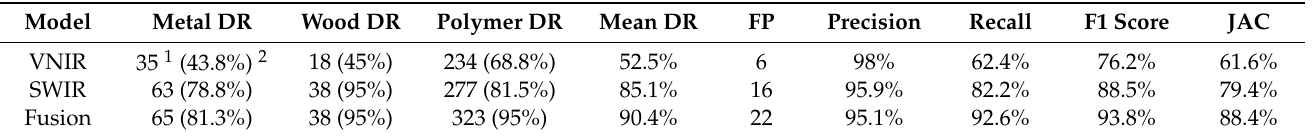
Table 4. Performance of three foreign material blob detection models on the test set. DR refers to detection rate. Model